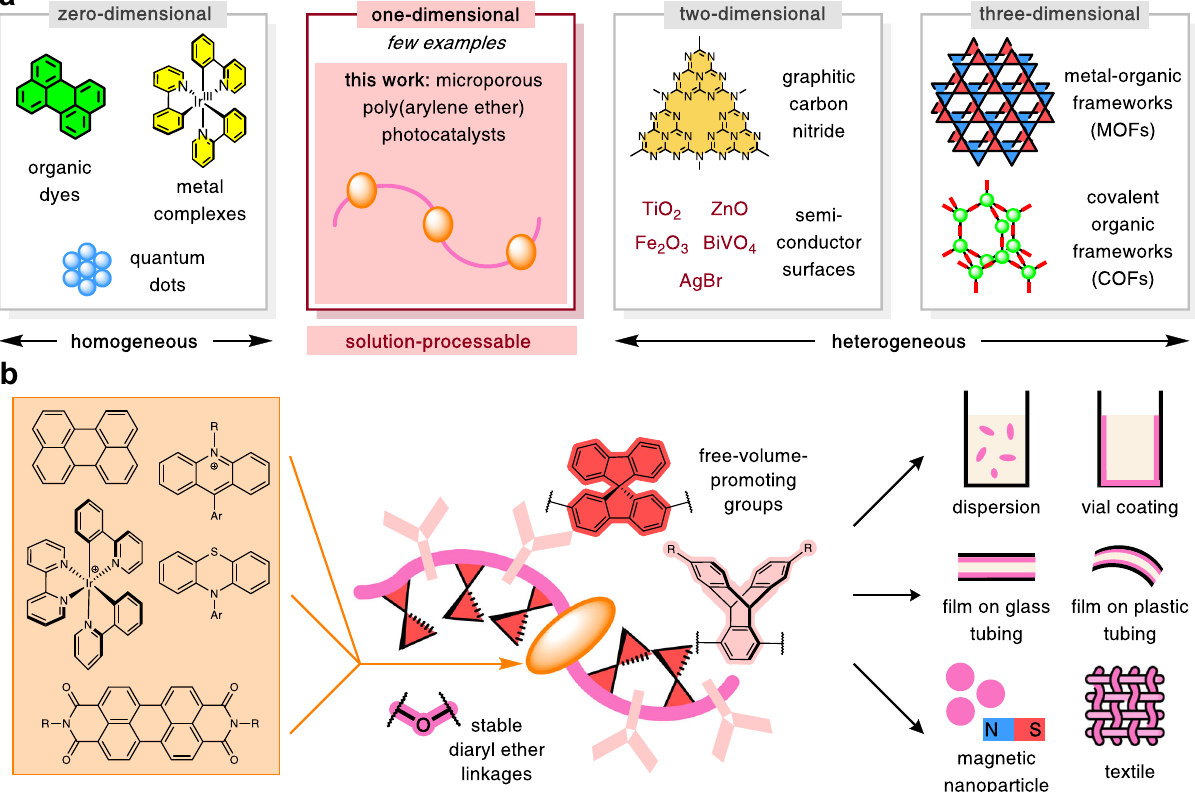
Fig. 1 Overview of photoredox catalyst design. a Classi fi cation of photoredox catalysts according to solubility and geometric dimension of active surface. b Transforming a broad scope of small-molecule photocatalysts into diverse heterogeneous materials through solution-processable